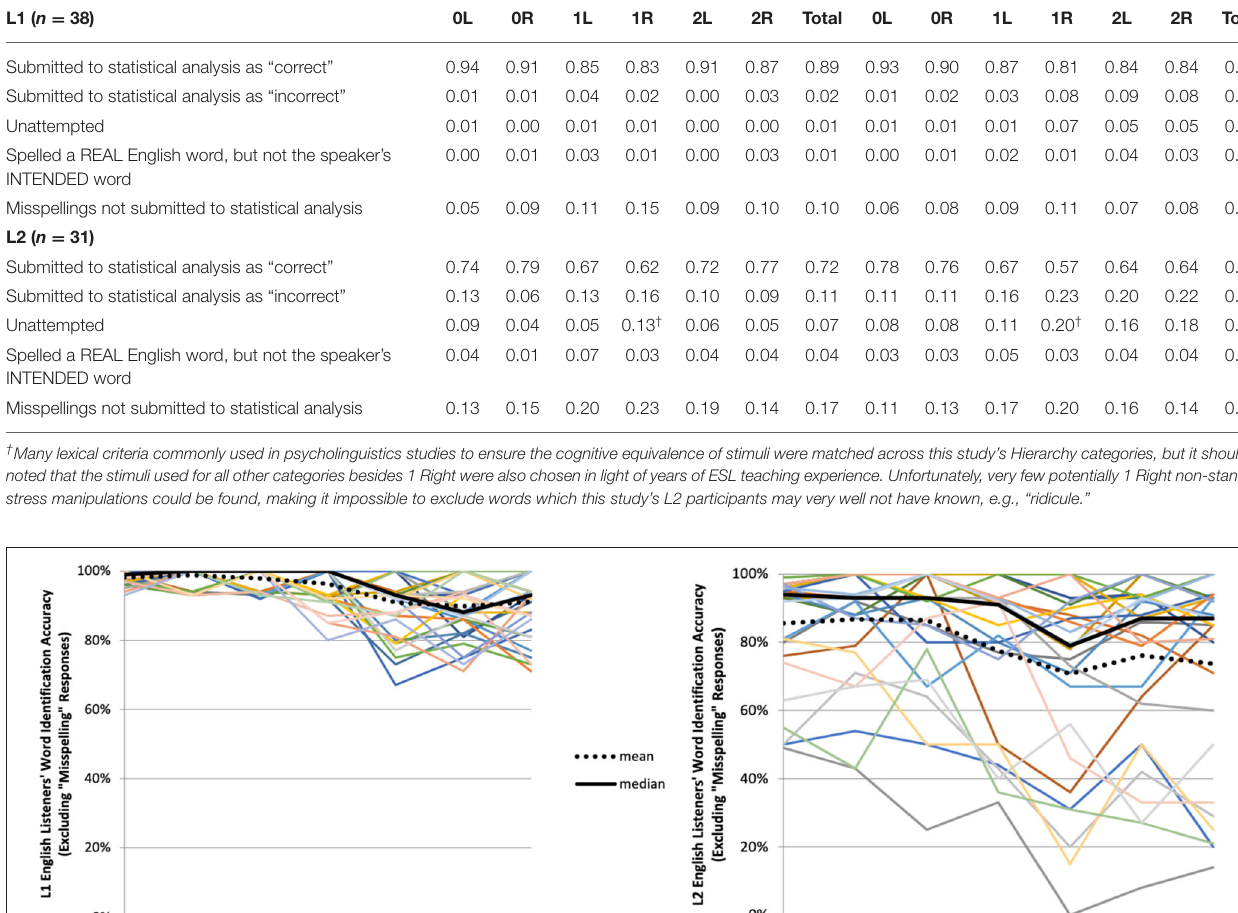
TABLE 5 | Percent of WI response tokens submitted vs. not submitted to statistical analysis. Standard pronunciation potentially as…